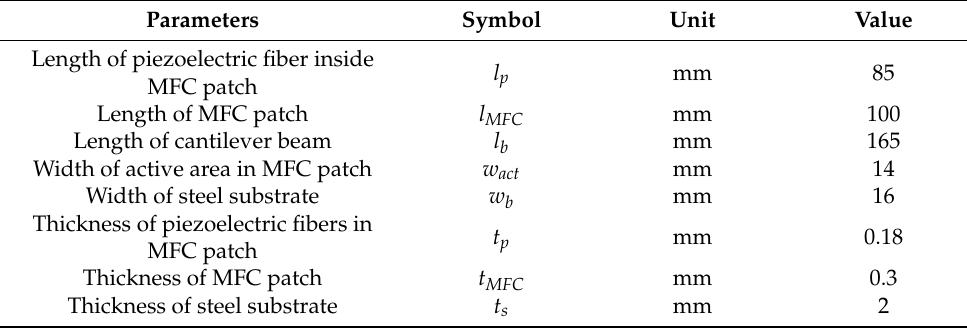
Figure 3. Schema of the vision system.